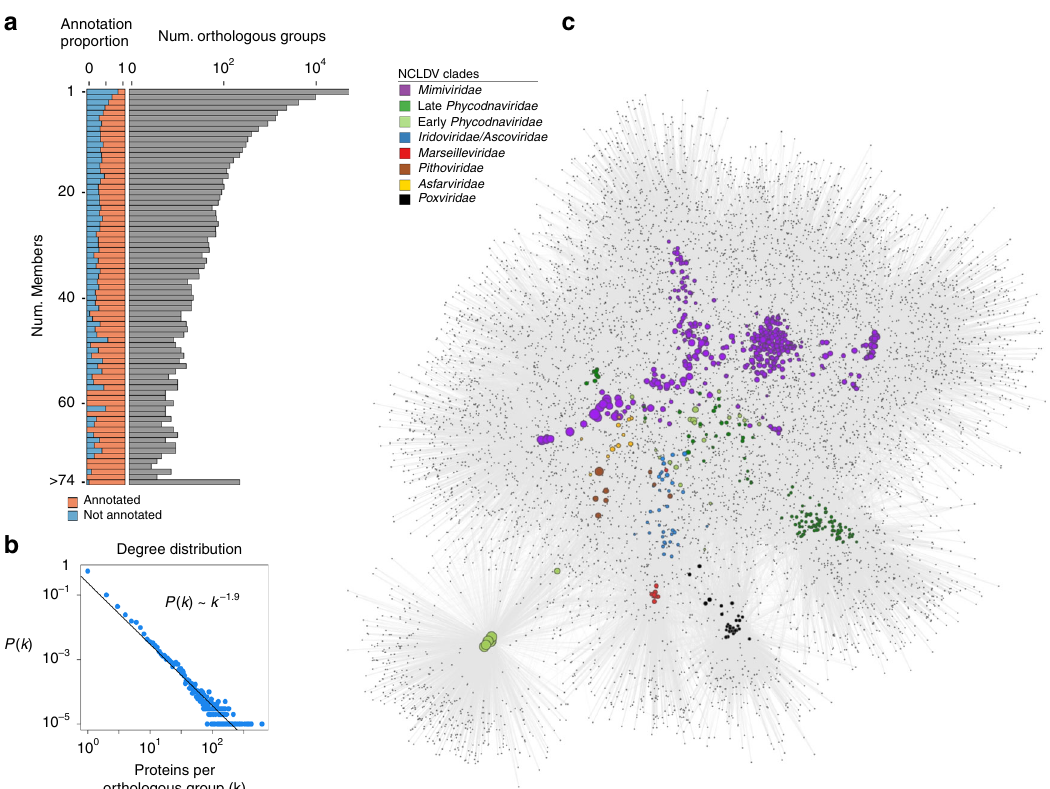
Fig. 2 Gene-sharing patterns of the NCLDV MAGs and reference genomes. a The distribution of the orthologous groups (OGs) in the NCLDV MAGs and reference genomes. The barplot on the left shows the proportion of OGs in each frequency category that could be assigned an annotation, while the barplot on the right shows the total number of OGs in each frequency category (log scale). b The degree distribution of the OG occurrence in the genomes analyzed. The best fi t to a power law distribution is also shown. c A bipartite network of the OGs, with large nodes corresponding to genomes and small nodes corresponding to OGs. The size of the genome nodes is proportional to their genome size, and they are colored according to their family-level classi fi